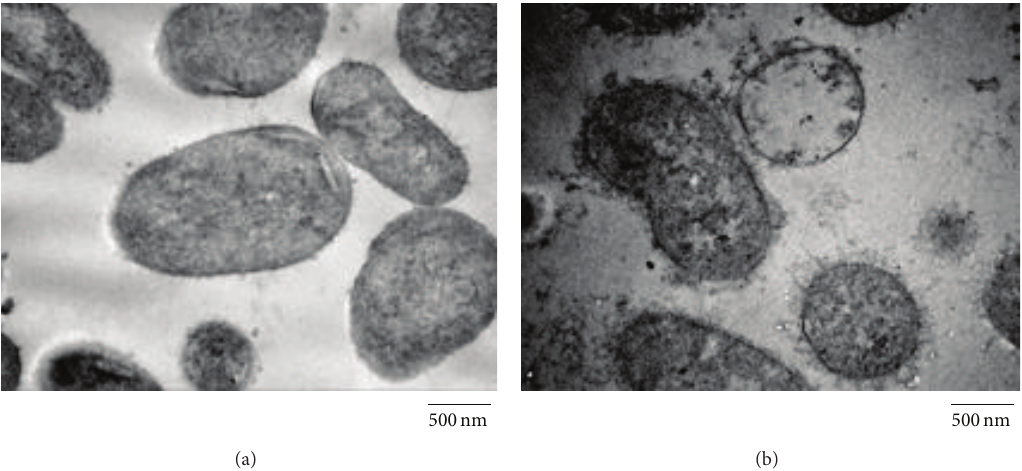
Figure 4: Ultrastructural damages in A. baumannii GIM1.650 treated with Mdc. Bacteria were untreated (a) or treated with Mdc (b) at a concentration of 8 𝜇 g/mL. Cells were processed to be analyzed under